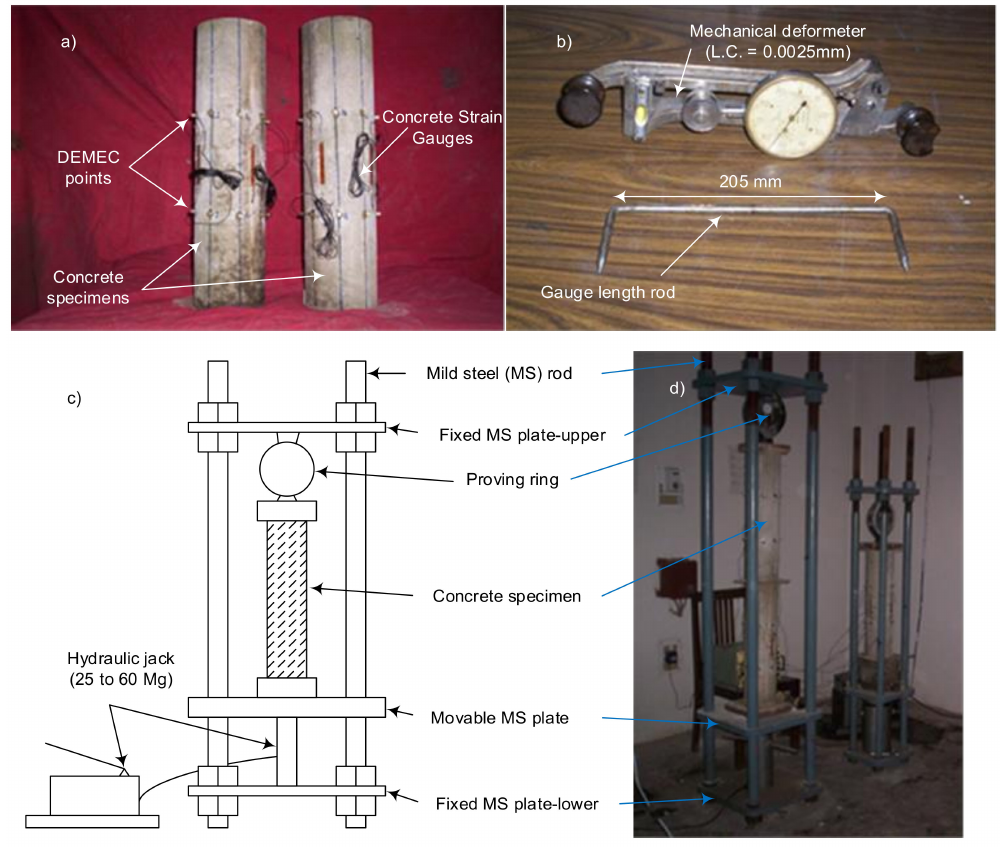
Figure 3. View of: ( a ) Prepared concrete specimens for creep strain measurement;( b ) mechanical deformeter; ( c ) scheme of creep strain test setup; ( d ) creep strain specimens during the